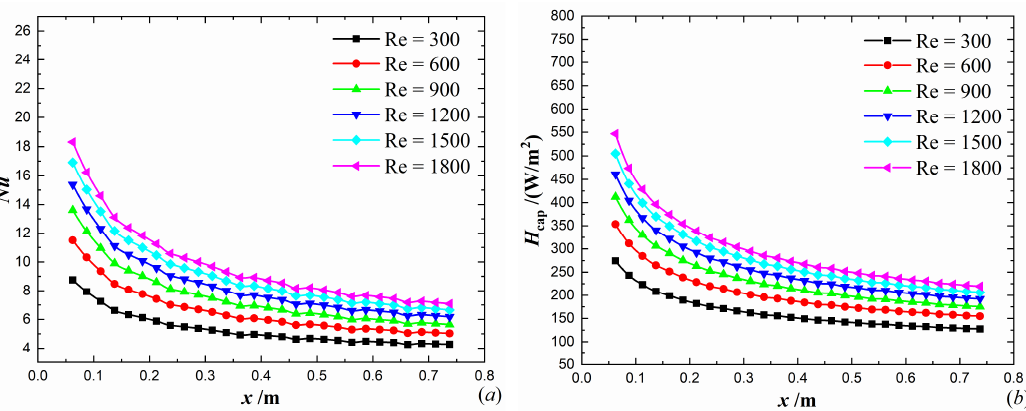
Figure 8. The variation of Nusselt number ( a ) and heat convection intensity ( b ) along the tube under the constant heat flux boundary.